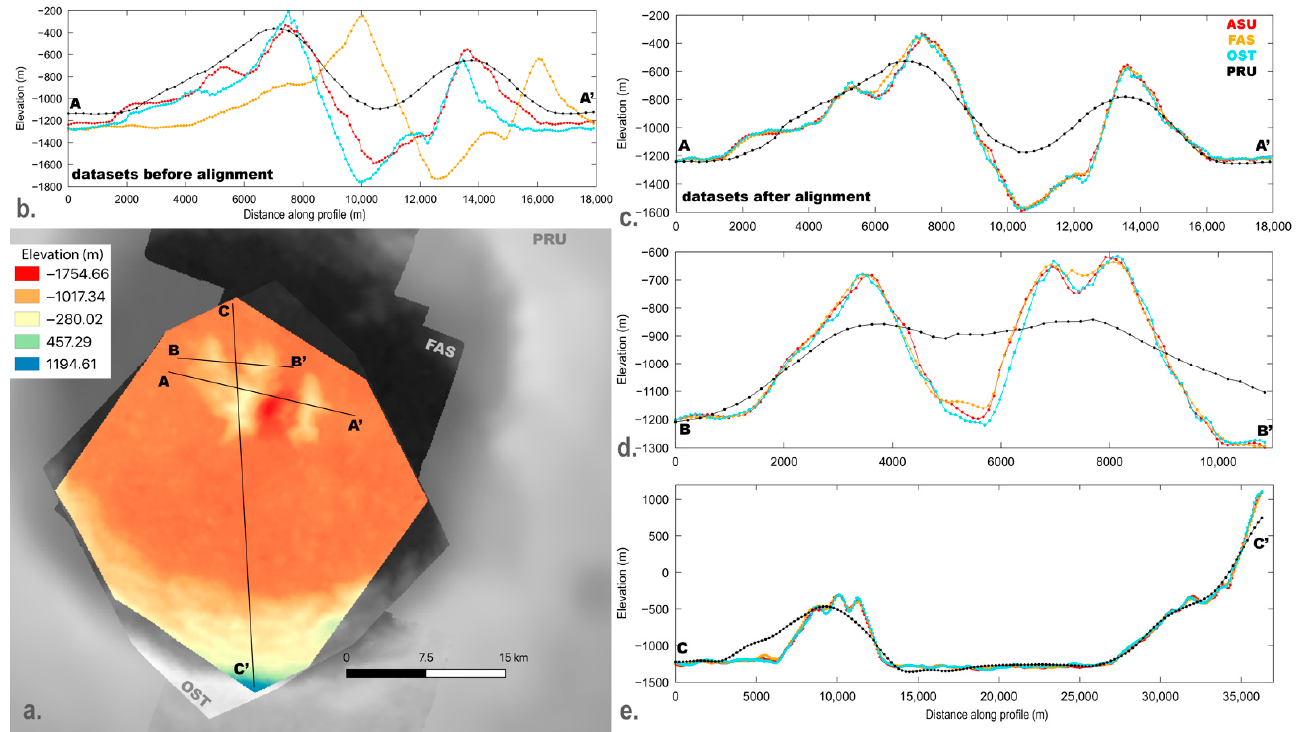
Figure 7. Degas crater profiles. ( a ) Colorized elevation map of ASU (97 m/px) shown over OST DEM (90 m/px), FAS DEM (95 m/px), and PRU H03 quadrangle (222 m/px). ( b ) Elevations for profile A for each DEM before alignment. ( c ) Elevations for profile A after alignment. ( d , e ) Post-alignment elevations for profiles B and C.